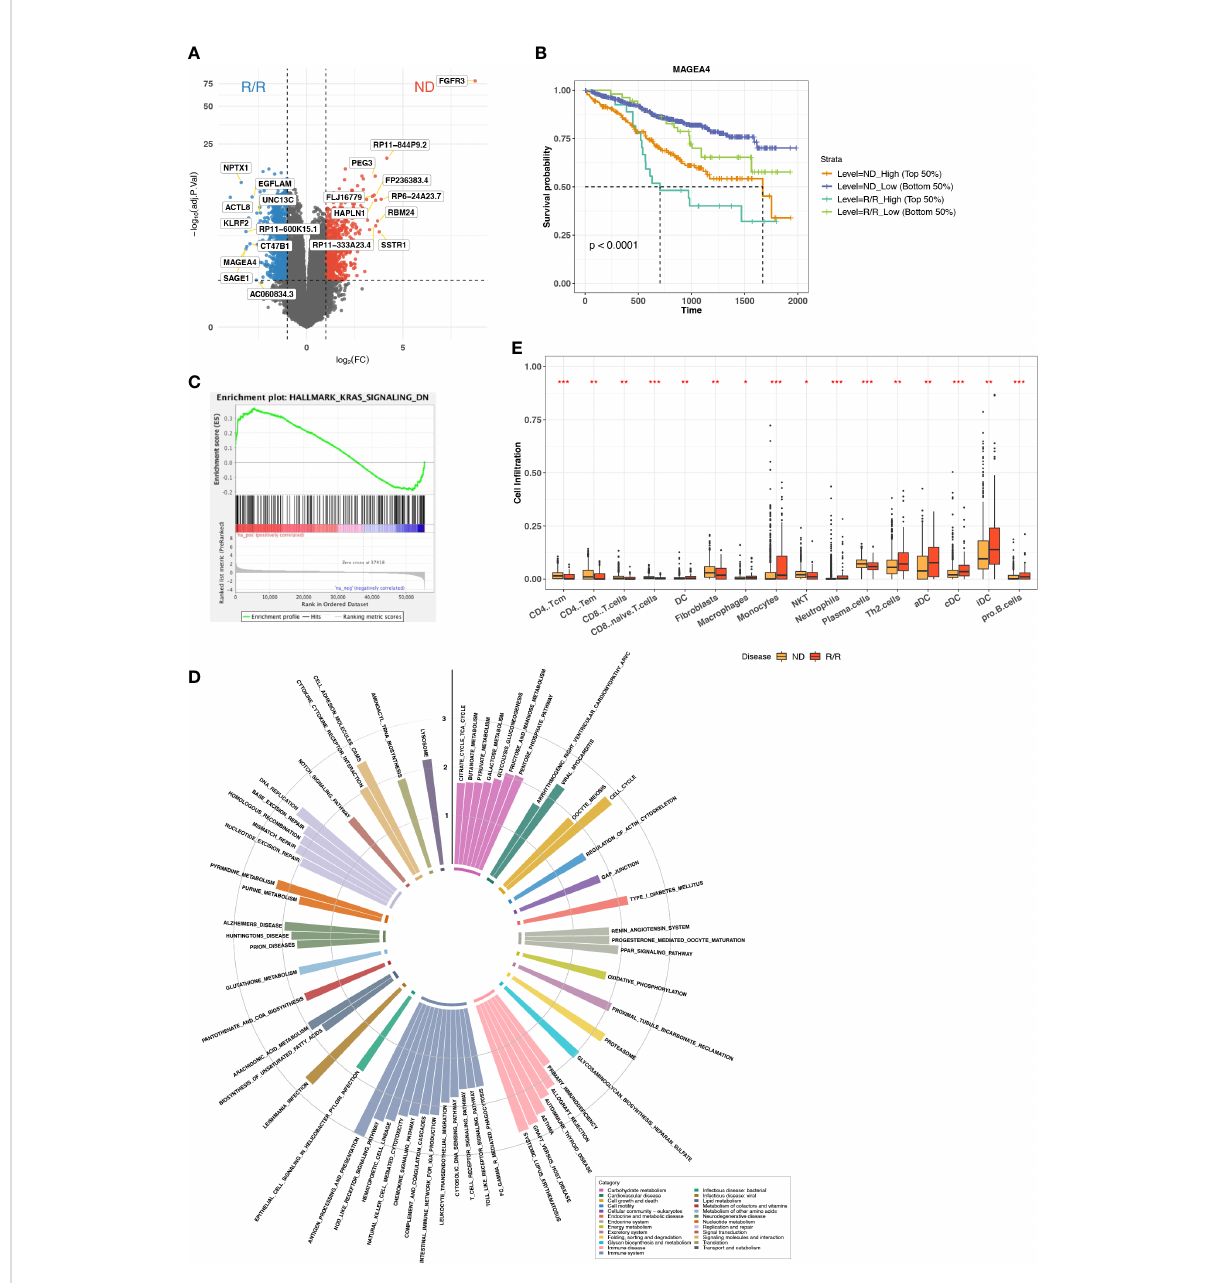
FIGURE 1 Immune microenvironment difference between ND and R/R MMs. (A) Differential expression analysis between ND and R/R MM tumors. Red dots indicate the top 10 upregulated genes in ND MM tumors, whereas blue dots indicate top 10 upregulated genes in R/R MM tumors. (B) Kaplan – Meier survival curve for MAGEA4 expression. (C) Enrichment plot from GSEA for KRAS signaling downregulation in ND MM tumors. (D) Normalized enrichment scores of tumor-upregulated KEGG pathways. Colors indicate different KEGG pathway categories. Asterisks denote signi fi cance level (*** FDR < 0.001; ** FDR < 0.01; * FDR < 0.05; NS FDR > 0.05). (E) Comparison of Cell in fi ltration estimated from xCell between ND and R/R MM tumors. Asterisks denote signi fi cance level (*** P < 0.001; ** P < 0.01; * P < 0.05; NS P >